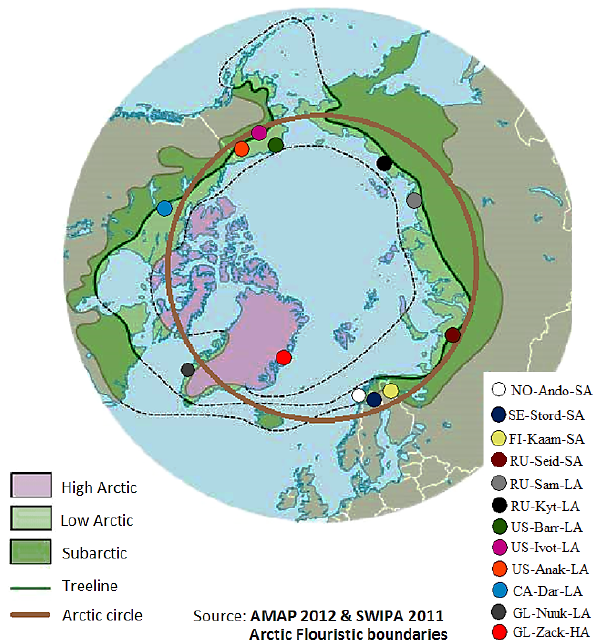
Figure 1. Location of study sites in a circumpolar context; classifi- cation according to Arctic floristic boundaries (AMAP,